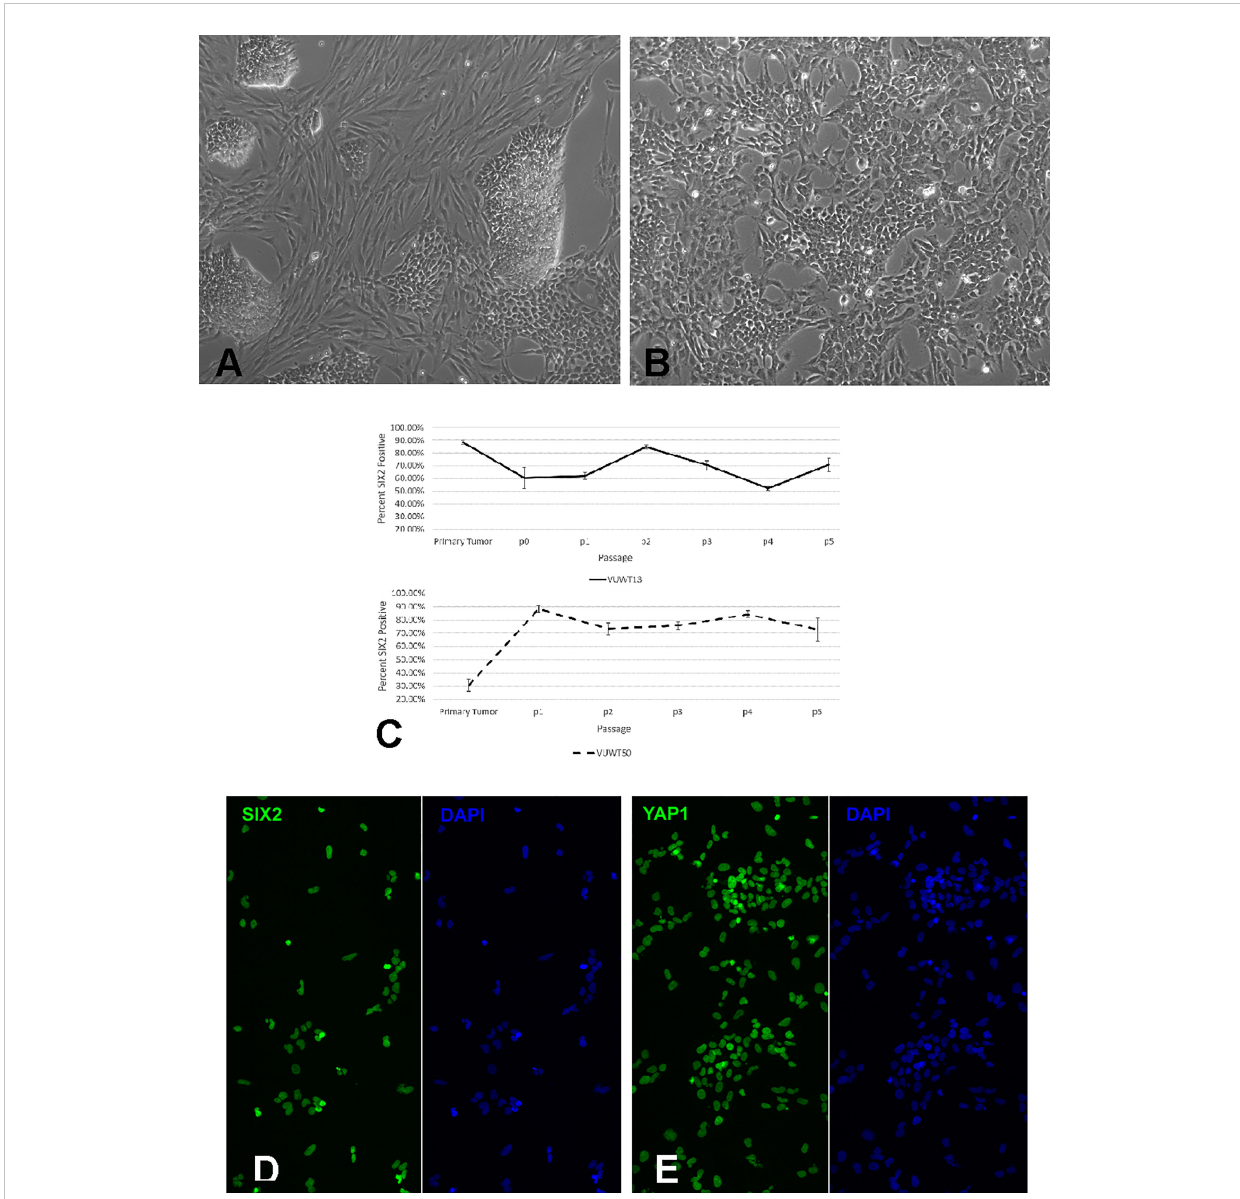
FIGURE 3 Analysis of cultured VUWT13 or VUWT50 tumor cells. (A) VUWT13 cells in culture directly from frozen tumor tissue, showing a mixed population of blastemal and stromal cells. (B) VUWT13 cell morphology in passage 5 cultures, showing primarily blastemal cell populations. (C) Flow cytometric analyses for Six2 expression in VUWT13 and VUWT50 through passage 5 cultures. (D) Immuno fl uorescence staining for SIX2 expression in p5 cultures of VUWT13 cells is predominantly nuclear localized. (E) Immuno fl uorescence staining for YAP1 expression in p5 cultures of VUWT13 cells shows prominent nuclear